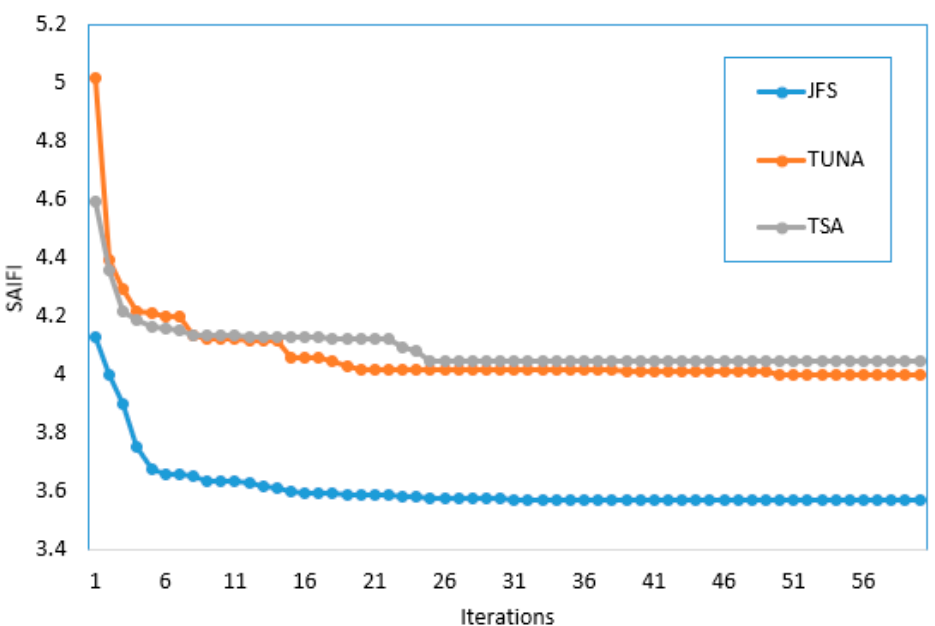
Figure 3. Convergence curves of TUNA, TSA and JFS algorithms for case 1.